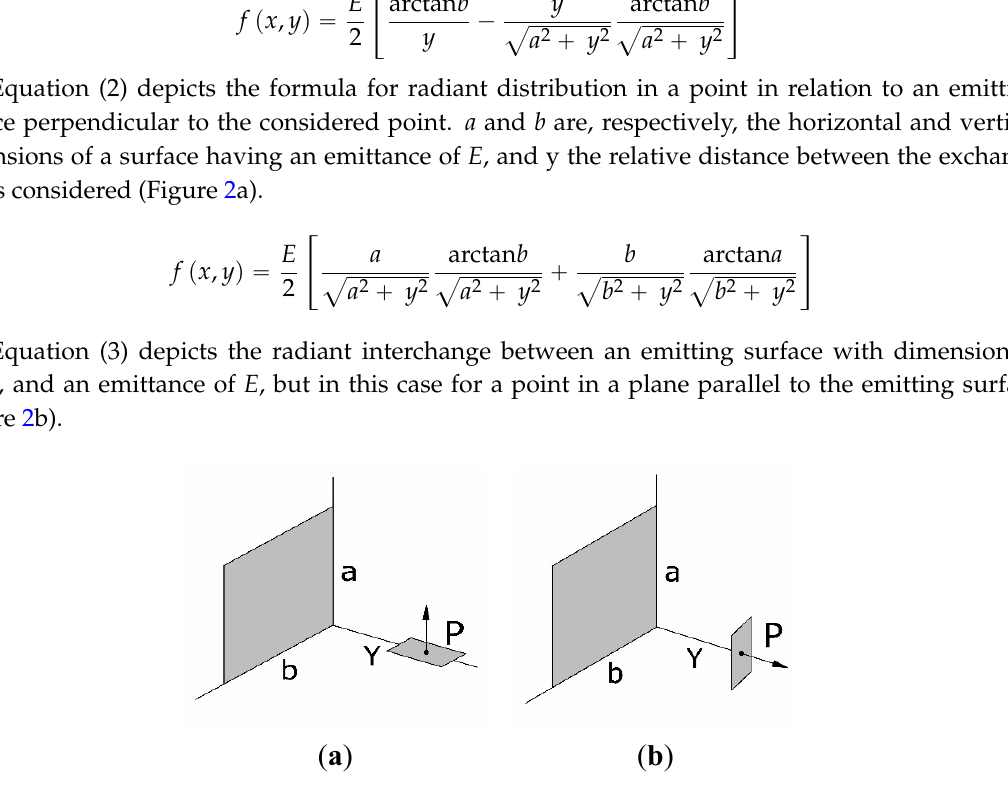
Figure 2. ( a ) Point in relation to an emitting perpendicular surface; ( b ) Point in relation to an emitting parallel surface.